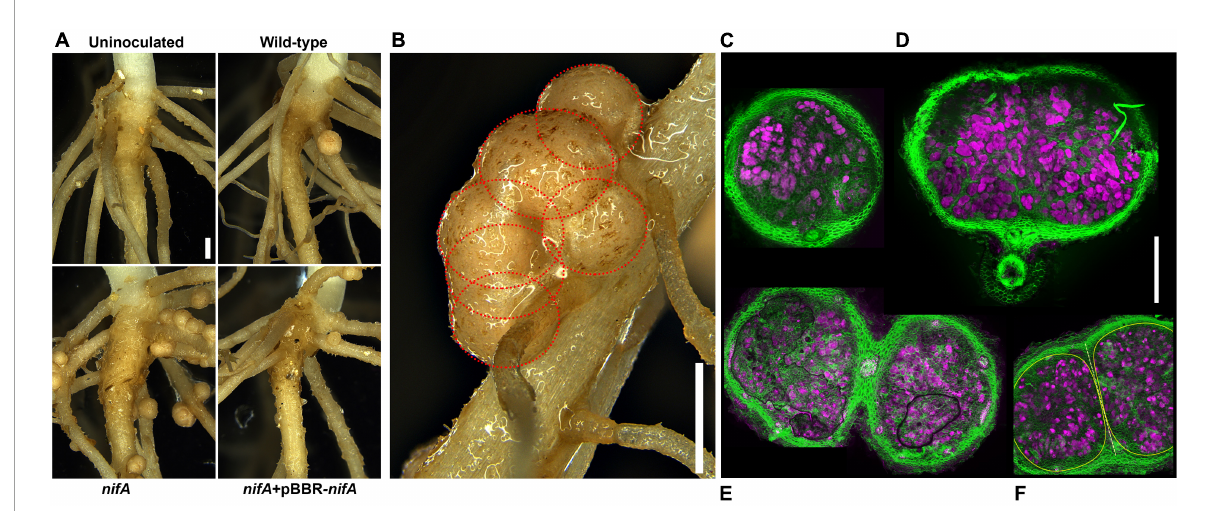
FIGURE1 nifA -triggered nodules that fuse during development. (A) Representative root-shoot junctions of 11 days post inoculation (dpi) Phaseolus vulgaris inoculated with or without the indicated strains. Bar = 1 mm. (B) Close-up view of an unusual structure formed by Paraburkholderia phymatum nifA -occupied nodules. The red dotted circles delineate the boundaries of six independent but intertwining nodules. Bar = 1 mm. (C–F) Confocal laser scanning micrographs of nodular transversal sections. Maximum z-projections of 30 µ m × 1 µ m optical sections. Calcofluor white staining of plant cell walls (green) and Syto9 DNA staining of bacteroids (magenta). Single wild-type or nifA- triggered young ( C , here colonized by wild-type P. phymatum ) or mature ( D , here colonized by P. phymatum nifA mutant) nodules are indistinguishable at macroscopic scale, respectively. (E) Two closely developing nifA nodules sharing cortical and vascular tissues (black lines delineate air bubbles produced in the mounting of the sample). (F) Fused nifA nodules (yellow outlines) separated by a cortical wall (dashed line). Bar = 500 µ